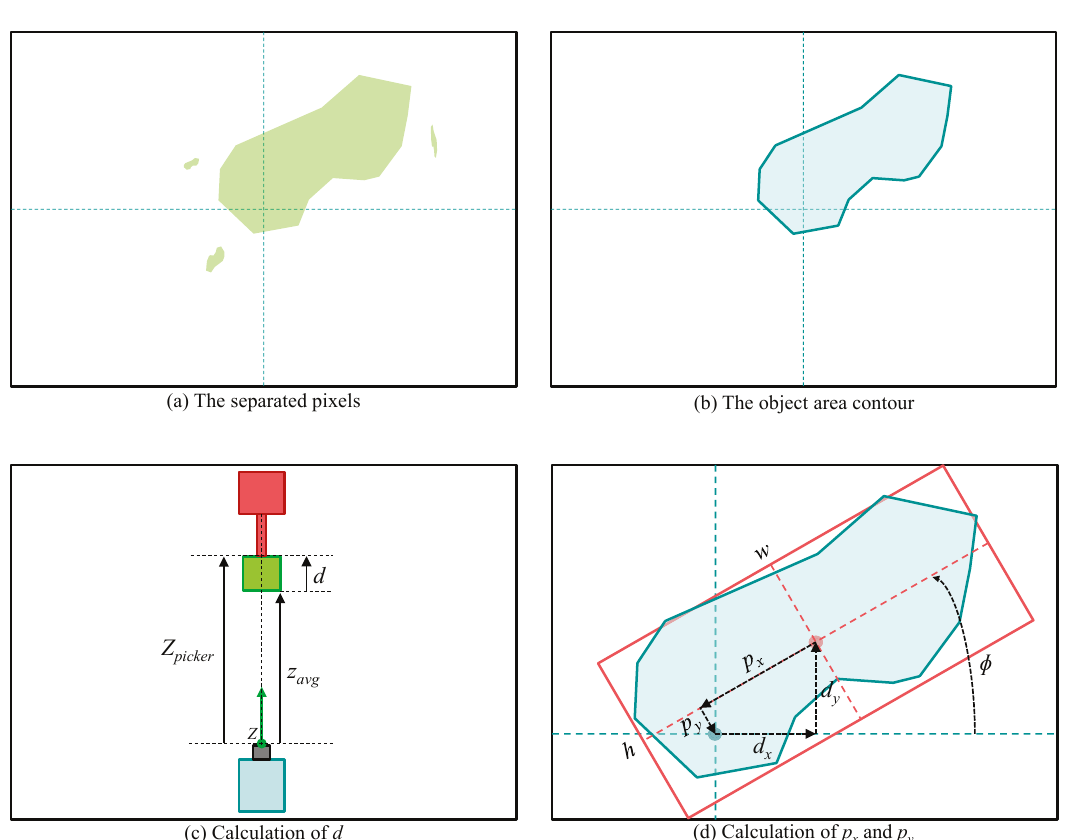
Figure 3. The procedure of the object